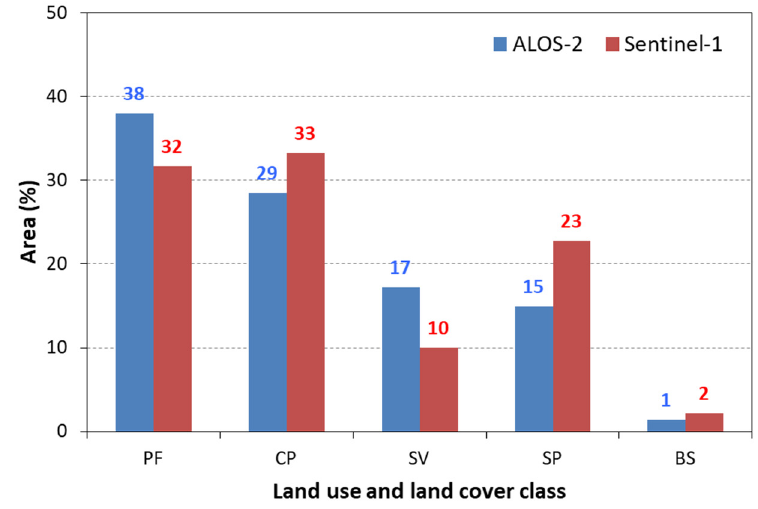
Figure 8. Area (%) occupied by each land use and land cover class considered in this study, esti- mated by the Random Forest algorithm based on the ALOS-2 and Sentinel-1 images. PF = primary forest; CP = clean pasture; SV = secondary vegetation; SP = shrubby pasture; and BS = bare